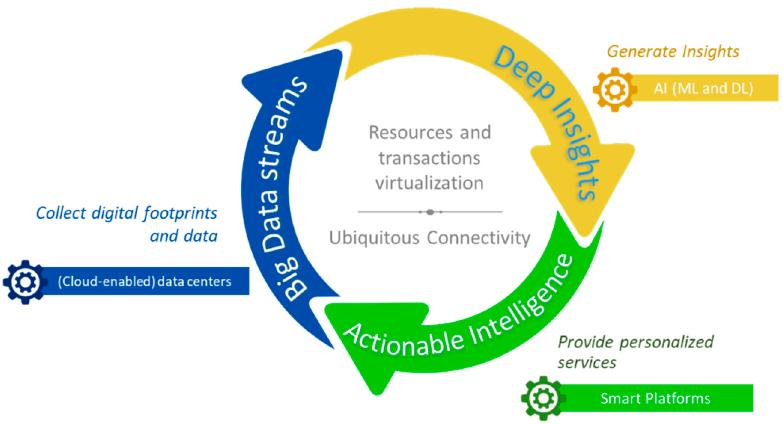
Figure 1. Conceptual “datafication” paradigm to generate actionable intelligence from data streams .